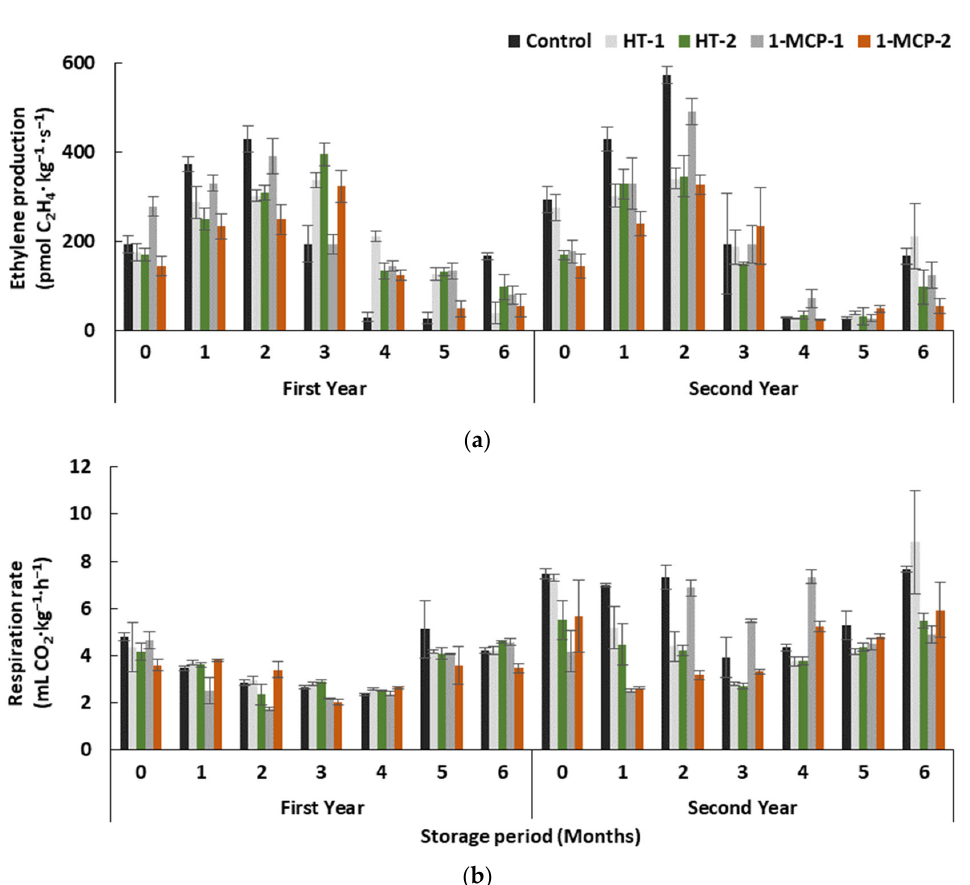
Figure 1. The effect of different postharvest treatments on ethylene production ( a ) and respiration rate ( b ) of the quince fruit during long-term cold storage period of 6 months at 0 ± 1 ◦ C, 85–90% relative humidity and regular air conditions. Control—without postharvest treatment; HT-1—Hot water treatment at 50 ± 1 ◦ C for 3 min; HT-2—Hot water treatment at 50 ± 1 ◦ C for 5 min; 1-MCP- 1—300 ppb 1-methylcyclopropane (1-MCP) treatment at 12 ◦ C for 20 h; 1-MCP-2—1000 ppb 1-MCP treatment at 12 ◦ C for 20 h. Vertical lines are the standard error of